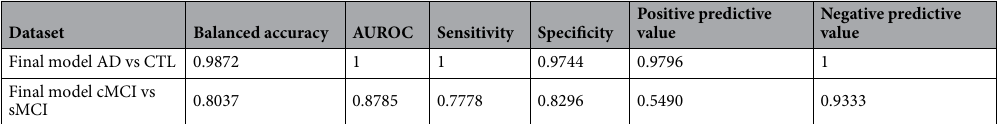
Table 4. Performance of the final classification model. Performance of the final classification model in discriminating AD vs CTL and cMCI vs sMCI.